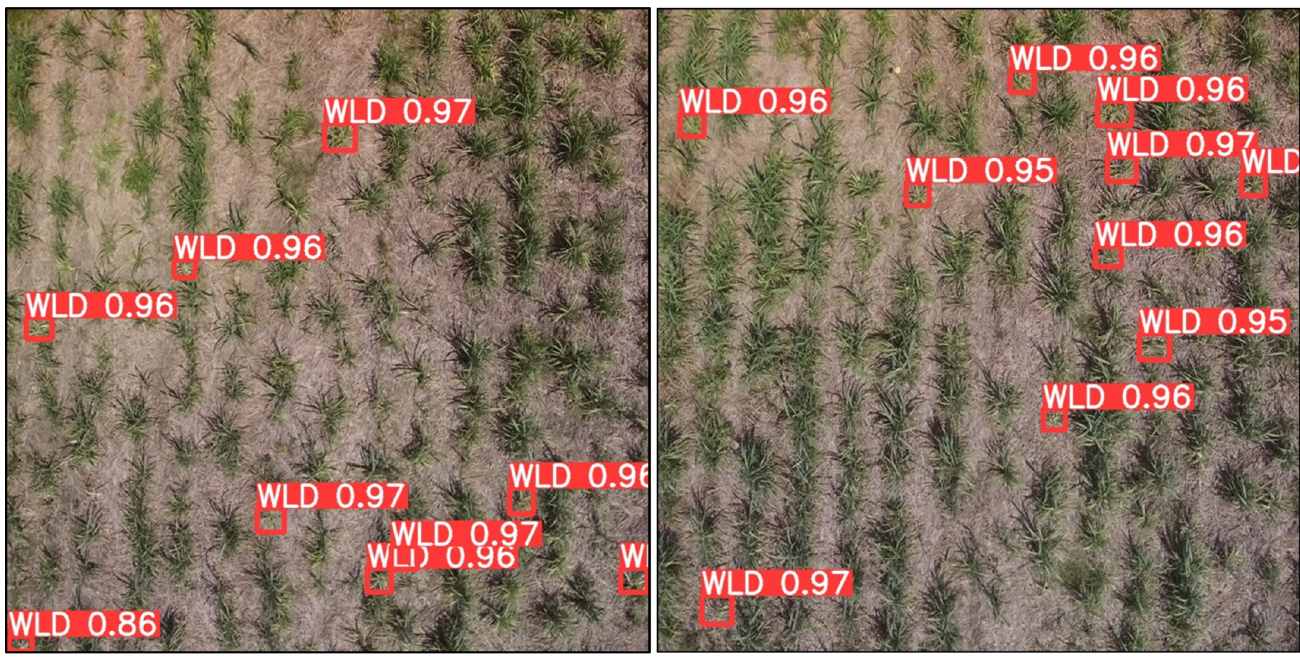
Figure 15. Bounding box detection using YOLOv5.